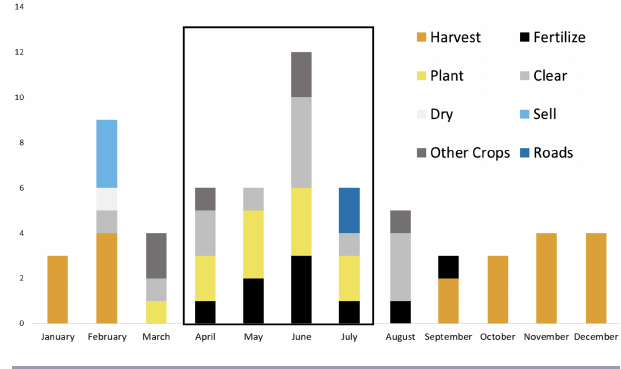
Fig. 4 . Coffee calendar from four communities (Palmor, San Javier, San Pedro, and Vista Nieve). Activities during the rainy season (amphibian reproductive season) are outlined in black box. Activities “dry, plant, harvest, clean, fertilize, and sell” relate to coffee plantations and crops, while “other crops” relates to time periods planting or harvesting additional crops, and “roads” relates to road maintenance done by local community